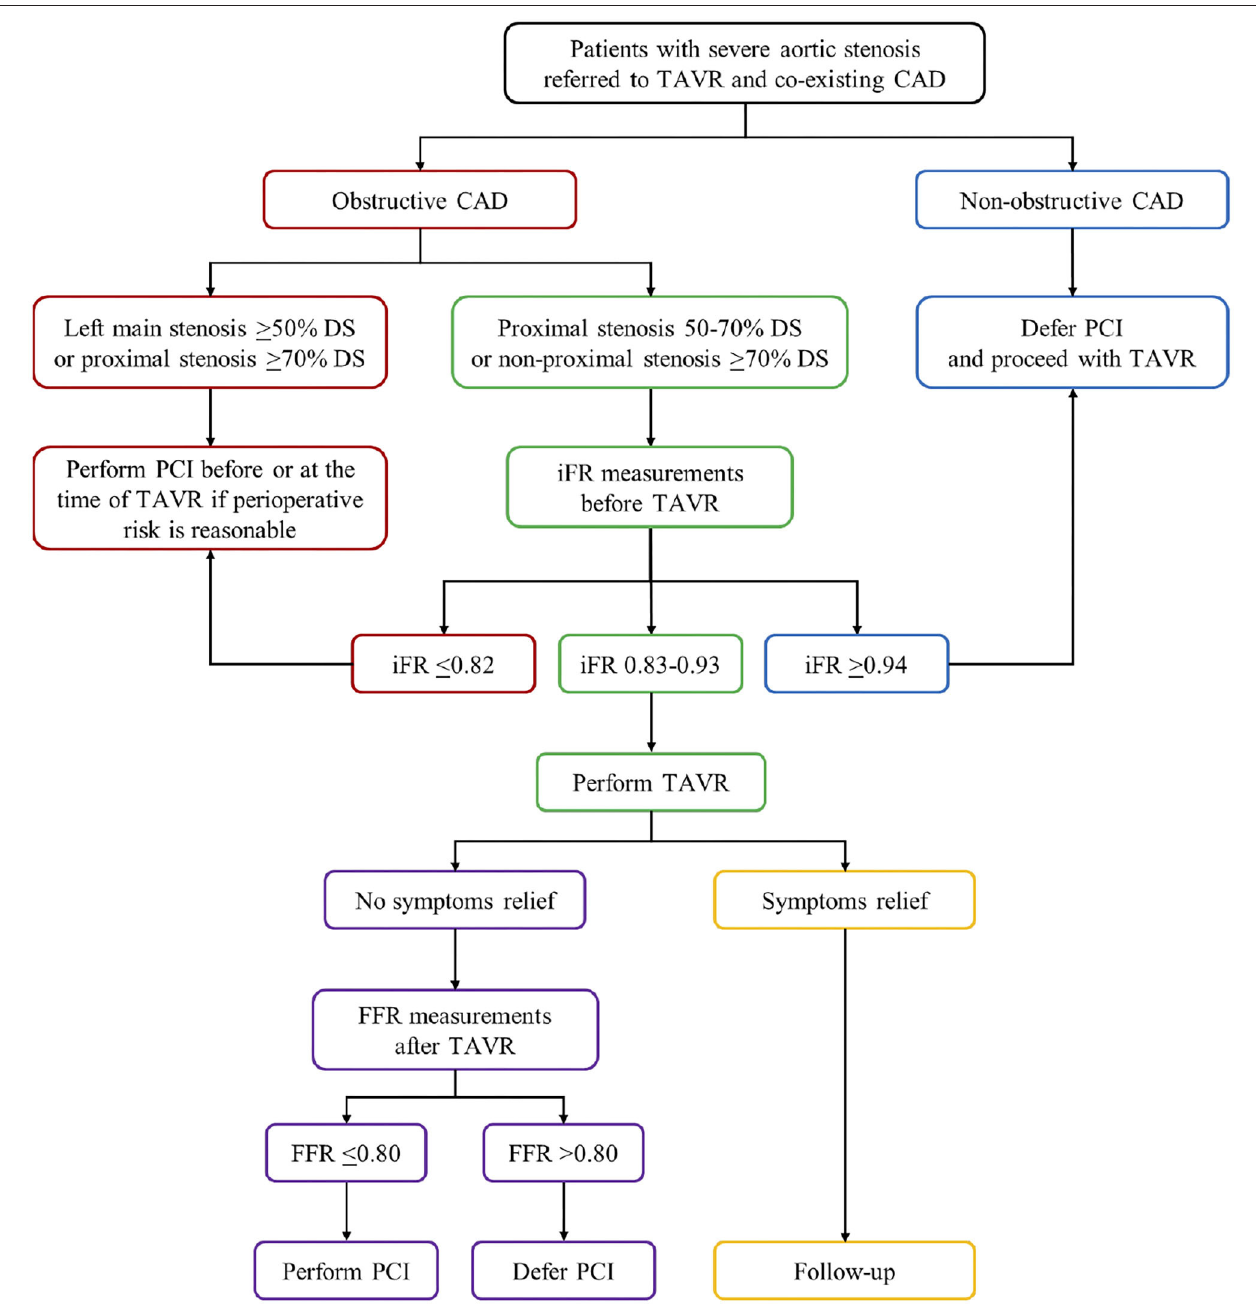
FIGURE 1 | The proposed flow chart illustrates the myocardial revascularization strategy in patients with severe aortic stenosis undergoing TAVR. Obstructive CAD is defined as coronary artery stenosis ≥ 50% DS. CAD, coronary artery disease; DS, diameter stenosis; FFR, fractional flow reserve; iFR, instantaneous wave-free ratio; PCI, percutaneous coronary intervention; TAVR, transcatheter aortic valve replacement.